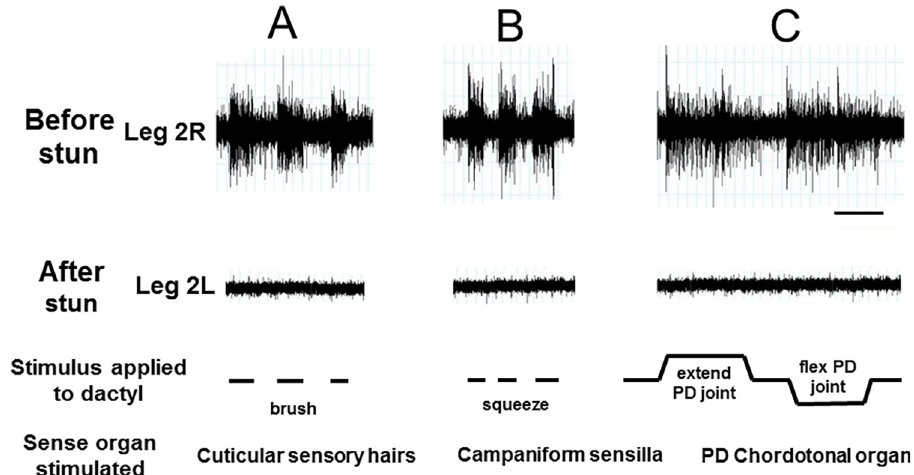
Fig 6. Recording sensory activity before and after electrical stunning. Responses of the leg nerve of C . pagurus preparation to three forms of stimulation of the dactylopodite (A-C) as indicated. Top panels, leg R2 autotomised from intact animal before stunning; lower panels, leg L2 amputated from same animal after electrical stunning. Scale bar 5 s.